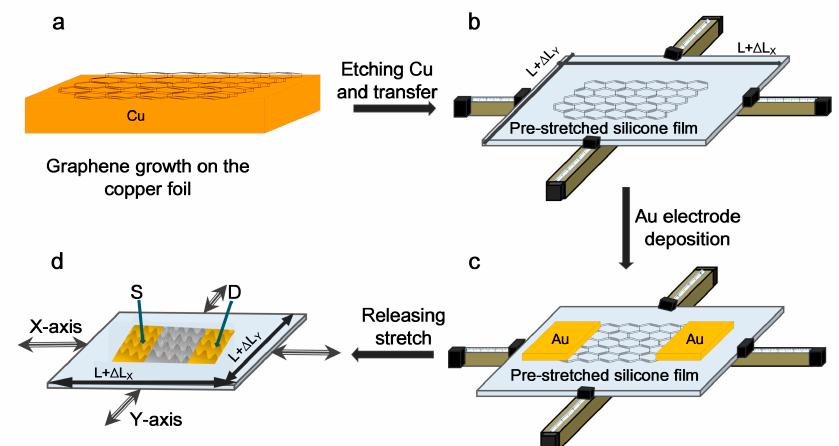
Figure 1. Schematic process of the preparation of crumpled graphene. ( a ) Graphene synthesized on a copper foil via thermal CVD; ( b ) transfer of post processed single layer graphene onto a pre-stretched silicone elastic film; ( c ) deposition of the Au electrode; ( d ) release of the silicone film to obtain crumpled